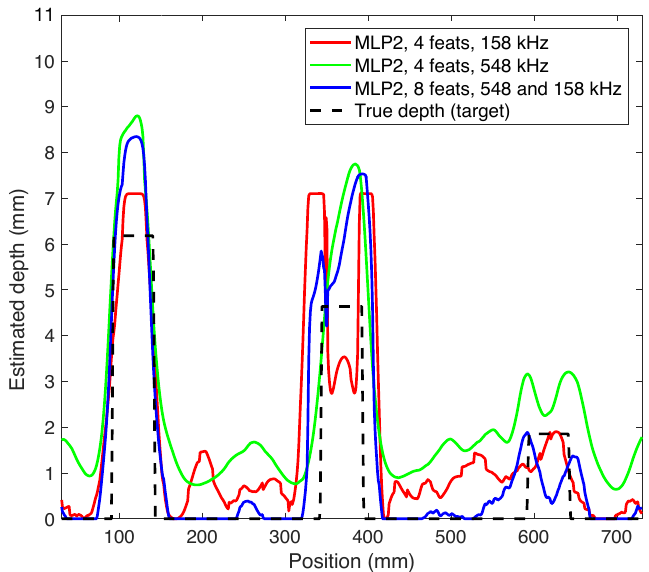
Figure 14. Estimation of the real pipeline